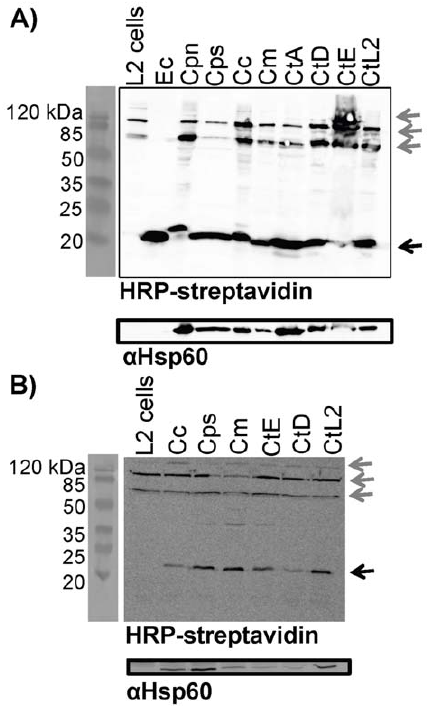
Figure 2. Detection of biotinylated proteins in Chlamydia . Protein samples were prepared from EBs (A) or L2 cells 20 hrs post infection (B) and separated on 12% SDS-PAGE for HRP-streptavidin Western blot analysis. E. coli lysates (Ec) and L2 cells were used as controls. The streptavidin reactive band unique to bacterial samples is indicated with a black arrow (right of blot) and prominent HRP- streptavidin reactive bands originating from host cell proteins are indicated with grey arrows (right of blot). Molecular weight markers are shown to the left of the blots. Control blots probed with anti-Hsp60 antibodies are shown beneath the HRP-streptavidin panels in panels A and B. Samples used were C. pneumoniae TWAR (Cpn), C. psittaci 6BC (Cps), C. caviae GPIC (Cc), C. muridarum NIGG (Cm), C. trachomatis serovar A (CtA), C. trachomatis serovar D (CtD), C. trachomatis serovar E (CtE), and C. trachomatis L2 strain434/Bu